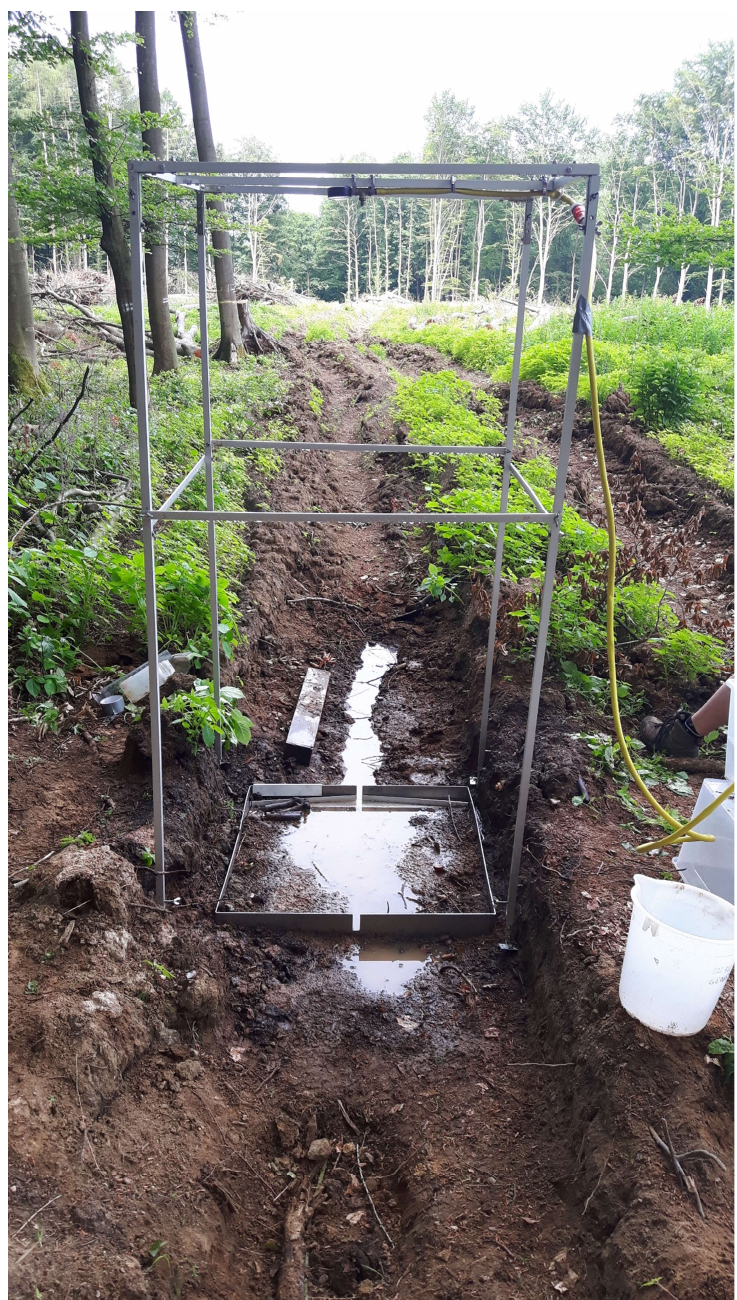
Figure 4. Rainfall simulator after a 30 min heavy rainfall simulation, positioned in a wheel rut. Relative position between cross sections 3 and 4 (cf. Figure